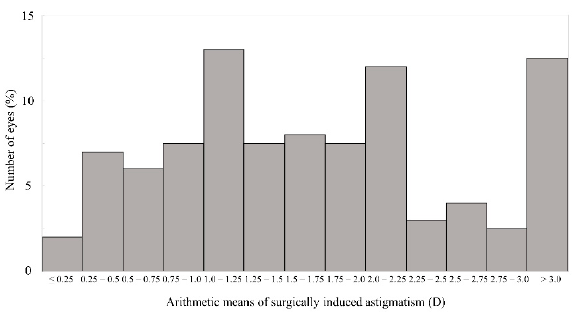
Figure 1. Graph showing the distributions of the preoperative corneal astigmatism and the intraoc- ular pressure.